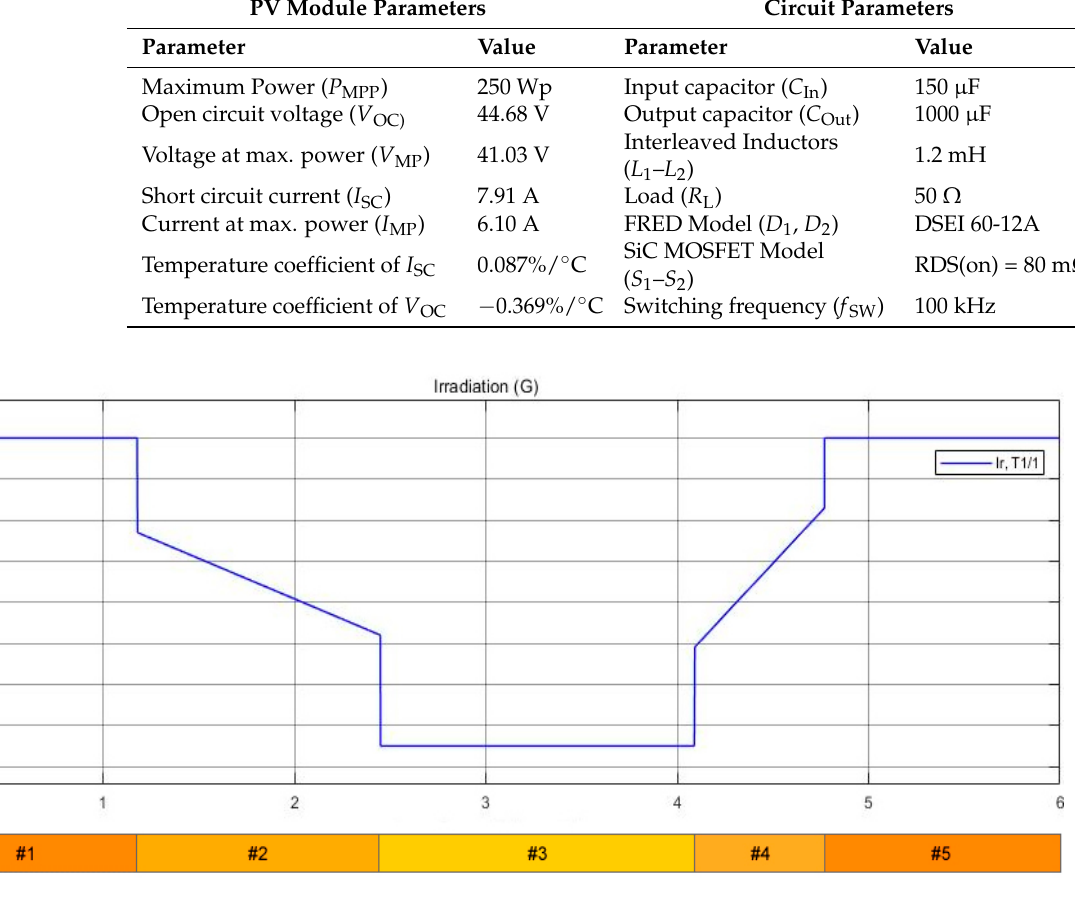
Figure 6. Irradiation conditions applied to test the MPPT controller.